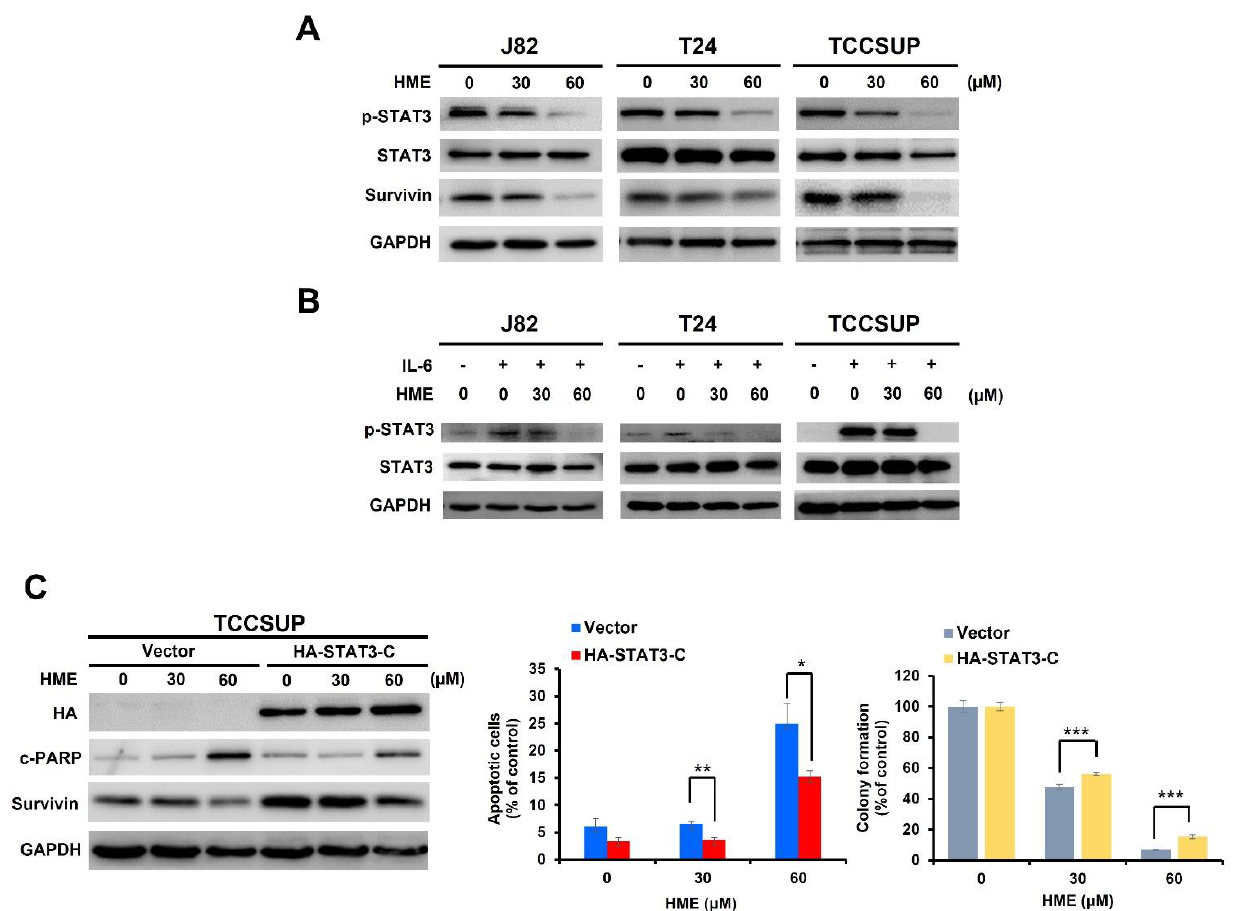
Figure 3. Blockade of STAT3 activation is a vital mechanism of HME’s anti-bladder cancer action. ( A ) HME inhibits constitutive STAT3 activation in human bladder TCC cell lines. J82, T24, and TCCSUP cells were treated with HME (0, 30, 60 µ M) for 24 h, followed by immunoblotting for the levels of tyrosine 705-phosphorylated STAT3 (p-STAT3), total STAT3, and survivin, a canonical STAT3 target gene. GAPDH levels were used for equal loading control. ( B ) HME inhibits IL-6-induced STAT3 activation in human bladder TCC cell lines. J82, T24, and TCCSUP cells were treated without or with HME (0, 30, 60 µ M) for 24 h in the absence or presence of IL-6 (100 ng/mL) stimulation for 30 min. The lysates from each treatment were subjected to immunoblotting for the levels of p-STAT3 and total STAT3. GAPDH levels were used for controlling equal loading. ( C ) Ectopic expression of STAT3-C (a dominant-active STAT3 mutant) impairs HME’s anti-bladder cancer activity. TCCSUP cells with stable expression of HA-tagged STAT3-C (HA-STAT3-C) and the respective vector control were treated with HME (0, 30, 60 µ M) for 24 h, followed by immunoblotting to determine the levels of HA, c-PARP, and survivin. GAPDH levels were used for equal loading control (Left). Moreover, the HA-STAT3 stable clones and the respective vector control clones after 24 h-treatment with HME (0, 30, 60 µ M) were subjected to annexin V/PI dual staining assay (center) and clonogenicity (right) for the evaluation of HME-induced apoptosis and cytotoxicity, respectively. *: p < 0.05; **: p < 0.01; ***: p <